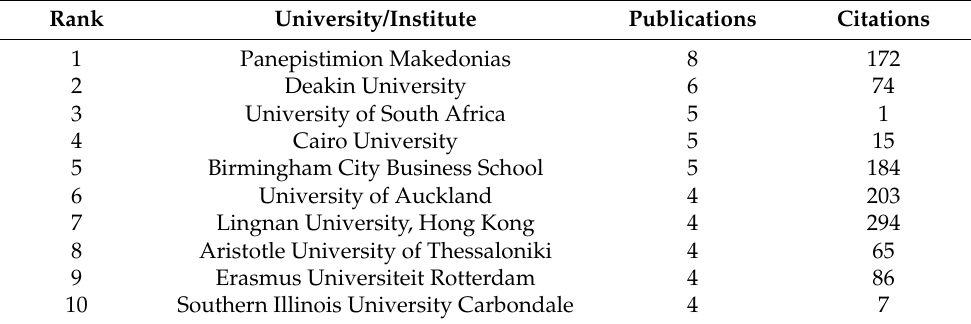
Table 3. The ten most productive universities.